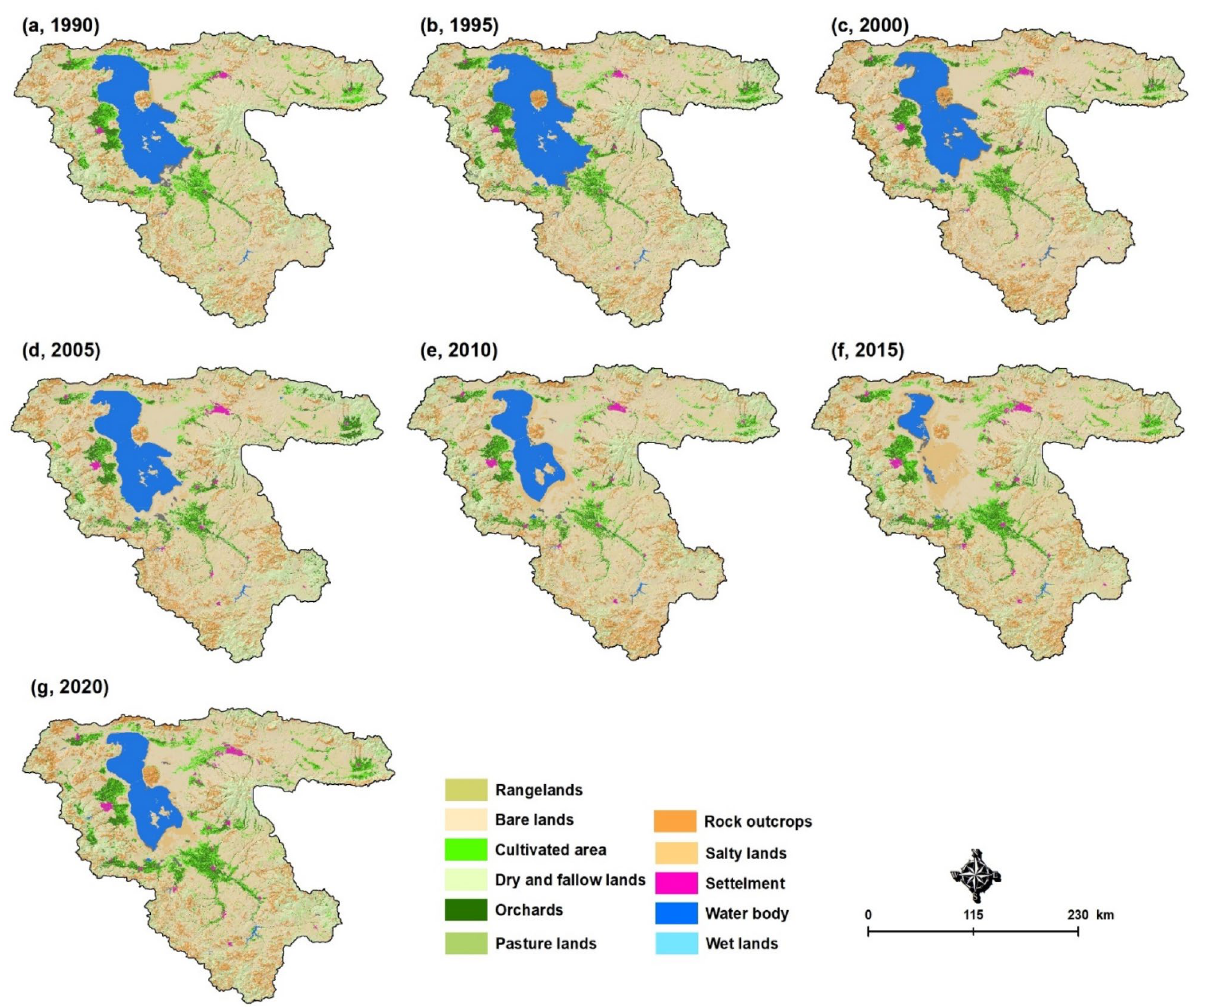
Figure 3. Results of the land use/cover changes monitoring and time series assessment in the Lake Urmia basin from 1990–2020, which show the increase in the area of farmlands, and the reduction of the rangelands over the past three decades. Figure created in Arc GIS 10.7 ESRI, https:// www. esri.